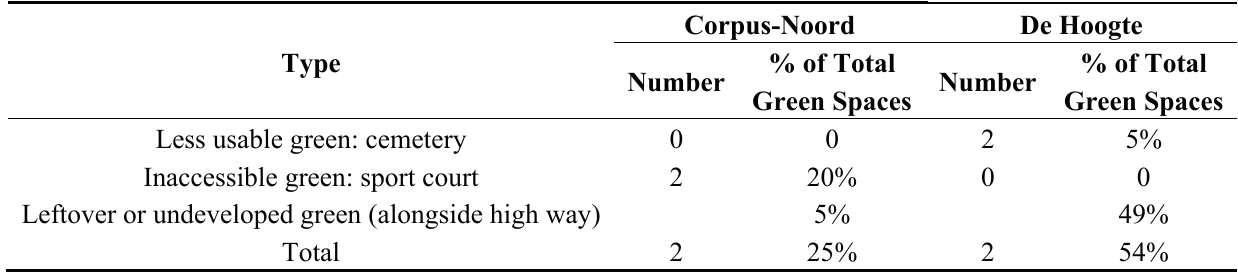
Table 2. Overview of inaccessible and less usable green spaces in the two